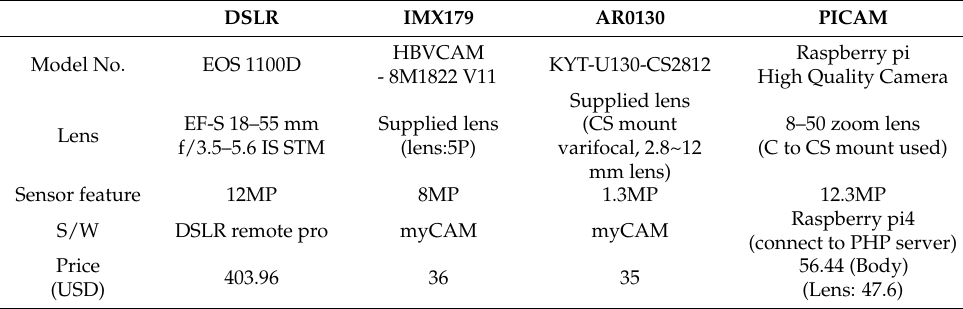
Table 1. Camera information.